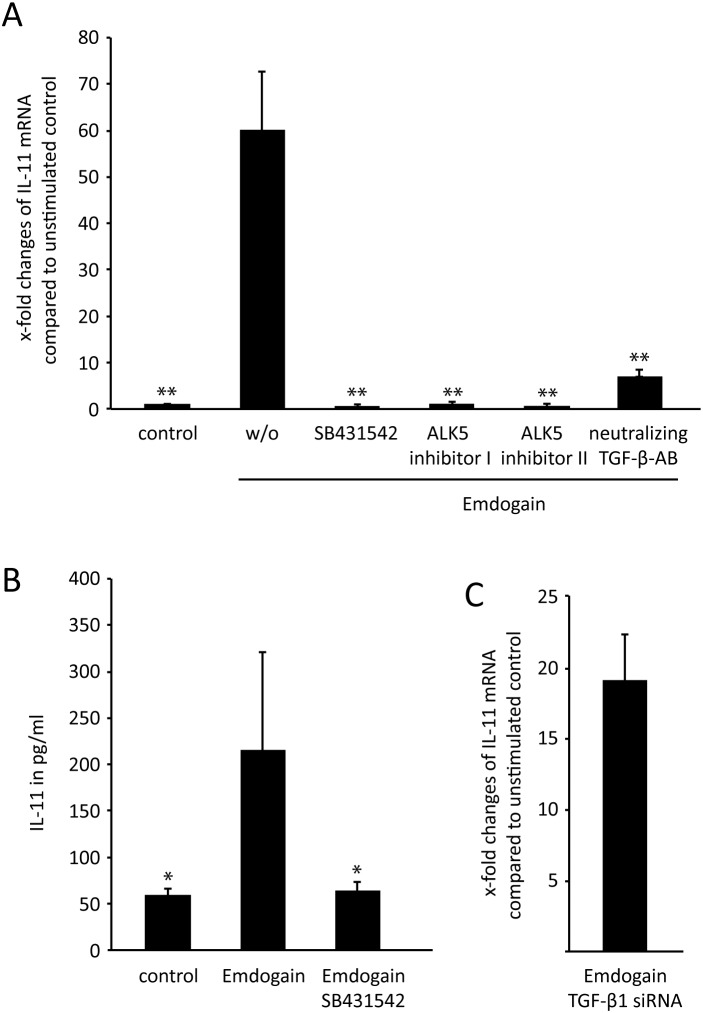
TGF-β receptor I kinase is crucial for IL-11 expression induced by Emdogain.Palatal fibroblasts were incubated with 100 µg/ml Emdogain or serum-free medium alone and the TGF-βRI kinase inhibitors SB431542, ALK5 Inhibitor I or ALK5 Inhibitor II and a neutralizing TGF-β pan-specific polyclonal antibody before RT-PCR was performed for IL-11 (A). The data represent 8 experiments including 4 donors. Immunoassay for IL-11 support the data at the protein level (2 experiments with 2 donors). **P<0.01 compared to Emdogain control (B). Palatal fibroblasts transfected with TGF-β1 siRNA and mock siRNA similarly respond to Emdogain by an increase IL-11 expression (C). The basal expression of TGF-β1-regulated genes SNAI1, SNAI2, and CTGF were around 50% decreased by TGF-β1 siRNA indicating that the transfection was effective (data not shown). The latter data represent one experiment with two donors (n = 2). Not shown is that Emdogain fails to change basal TGF-β1 expression.